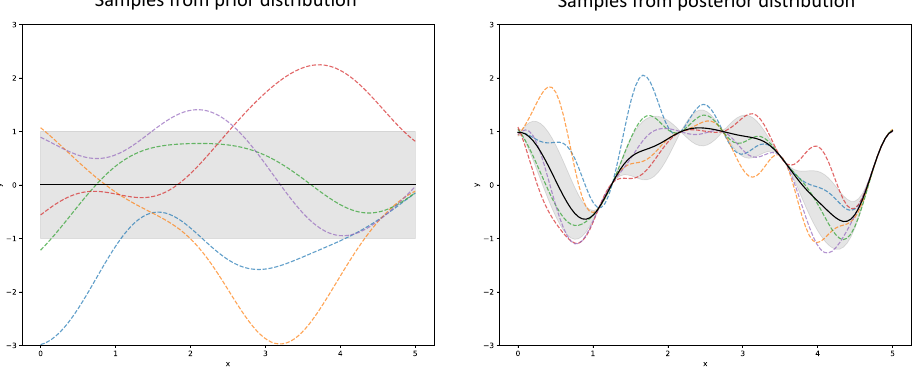
Figure 5. Examples of Gaussian process